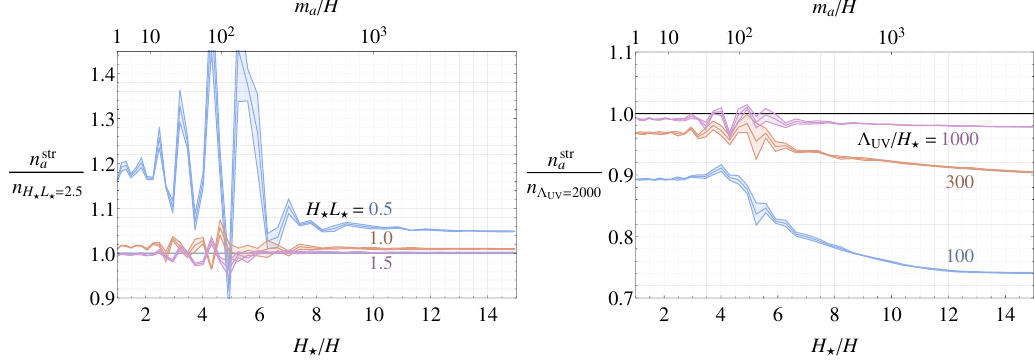
Figure 27: Left: The axion number density as a function of time for different choices of H (cid:63) L (cid:63) , normalized to the values closest to the infinite volume limit H (cid:63) L (cid:63) = 2.5. Right: the same observable for different choices the UV-cutoff of the spectrum Λ / H (cid:63) , normalized to results with the largest cutoff tested UV simulations are performed for the simplified initial condition spectrum with x and ξ (cid:63) log (cid:63) = 10 3 , and an axion mass power law α =